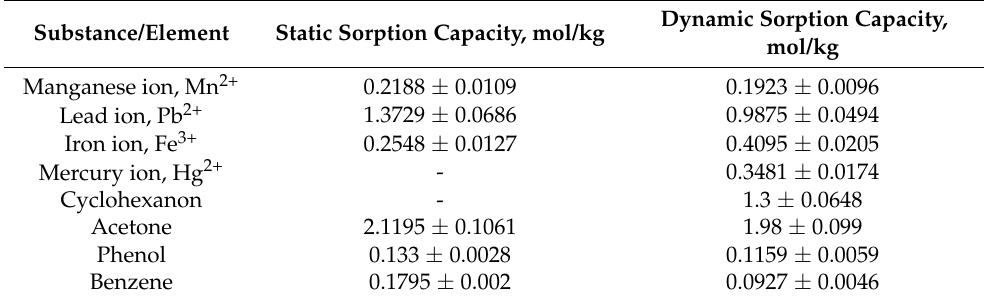
Table 11. Sorption characteristics of the investigated organic material (preliminary washed) at a temperature of 25 ± 2 ◦